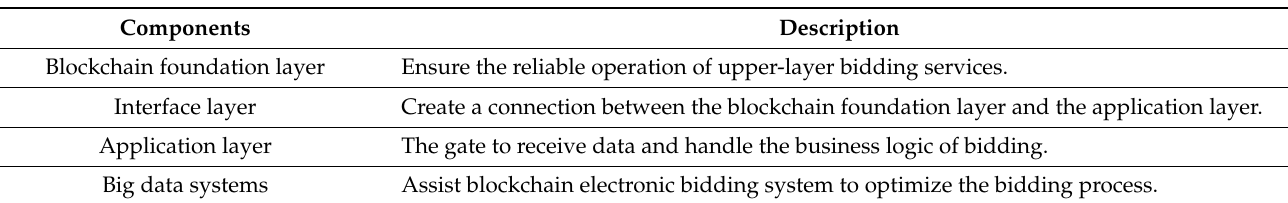
Table 3. The components of blockchain.